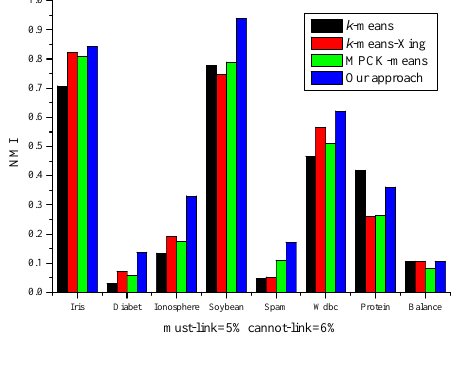
Fig. 2. The result comparison of NMI